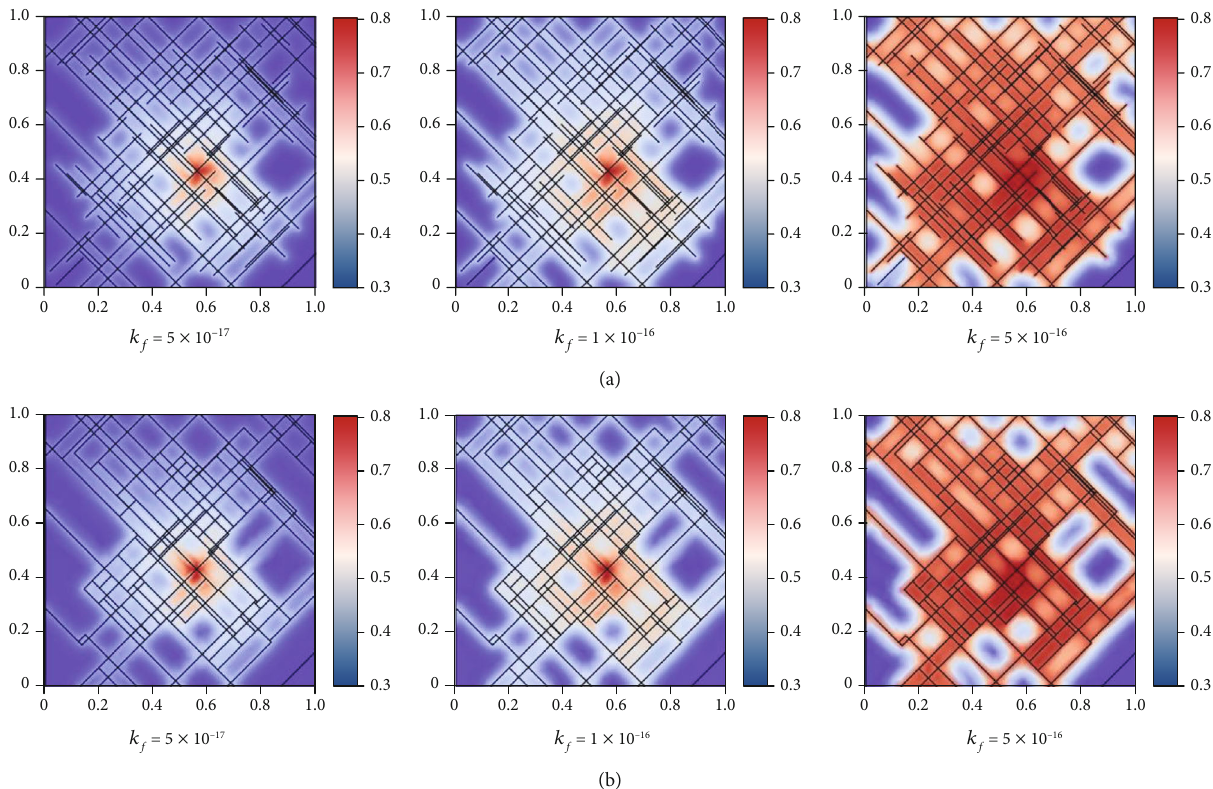
Figure 16: The spatial distribution of methane saturation after 2 : 0 × 10 s in Case a and Case b with di ff erent fracture permeabilities of k = 5 : 0 × 10 − 17 , 1 : 0 × 10 − 16 , and 5 : 0 × 10 − 16 m 2